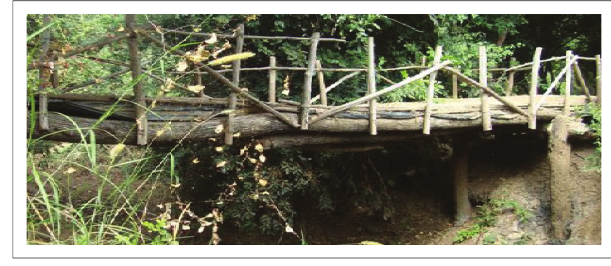
Source : Taken by C. Mudavanhu FIGURE 5: Footbridge constructed by local